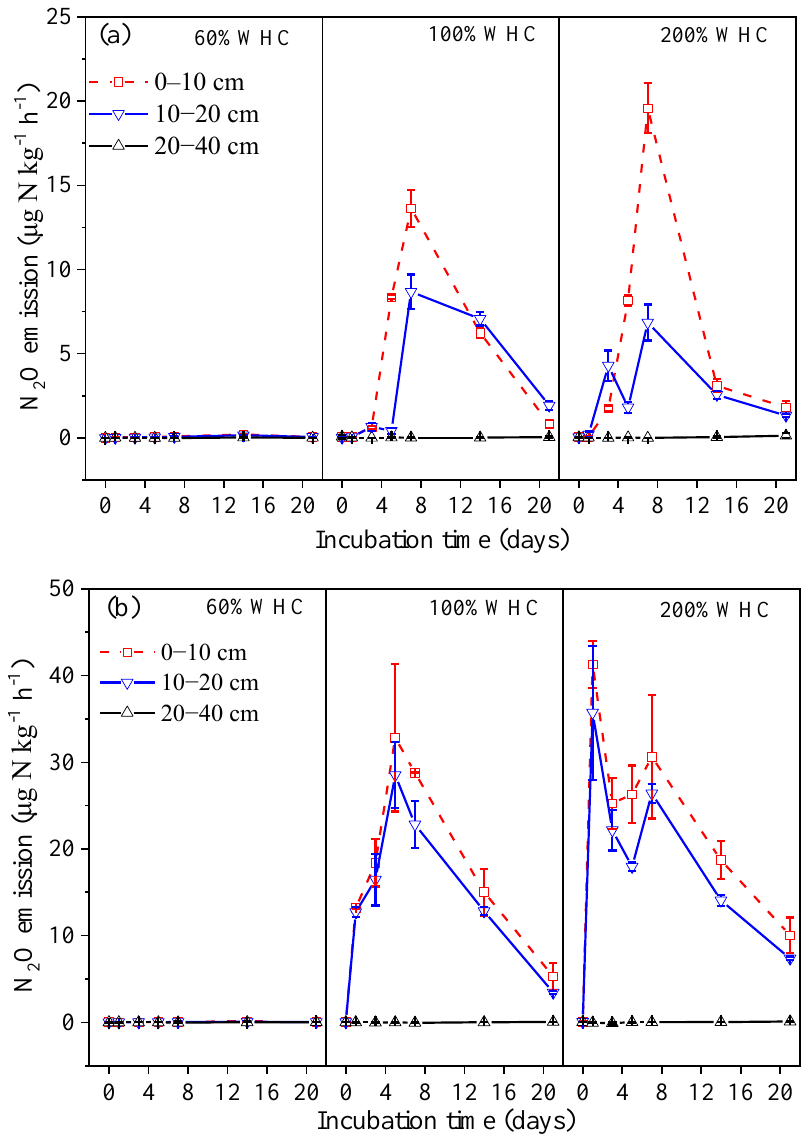
Figure 1. Effects of soil layers (0 – 10, 10 – 20, and 20 – 40 cm) and soil moisture (60%, 100%, and 200% WHC) on N 2 O emission rate in hydromorphic ( a ) and gleyed ( b ) paddy soils. Values are the means of three replicates, and the error bars represent standard errors.